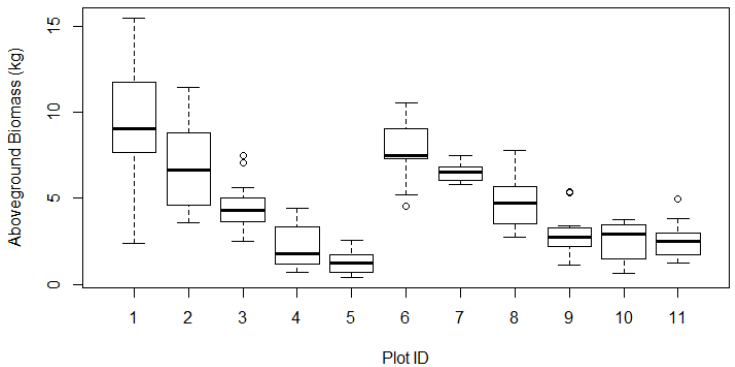
Figure 2. Boxplot of aboveground biomass in different plots in which the samples were destructively collected. Forests 2017 , 8 , 477